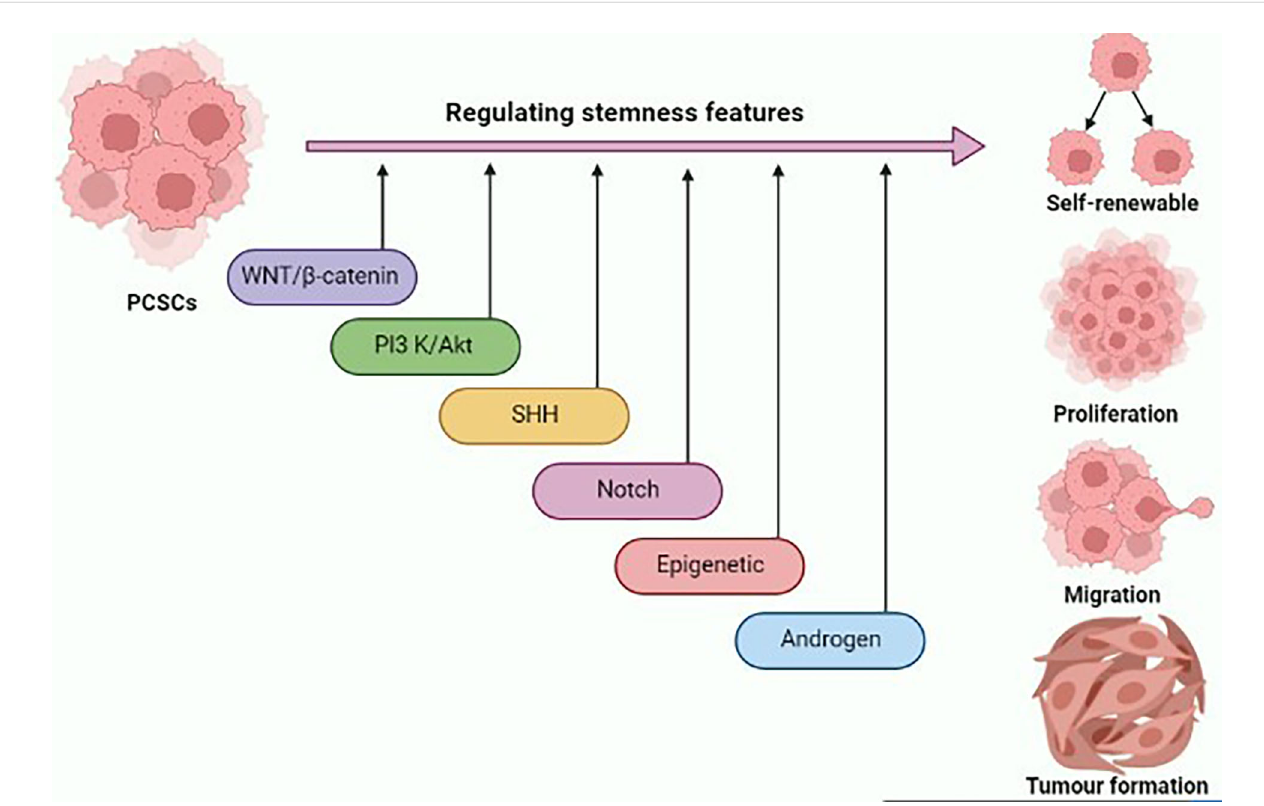
FIGURE 1 Graphical illustration representing the various signaling pathways and epigenetic landscape contributing to the regulation of stemness features of prostate cancer stem cells (PCSCs) such as self-renewal, proliferation, migration, and tumor formation. This fi gure was created with